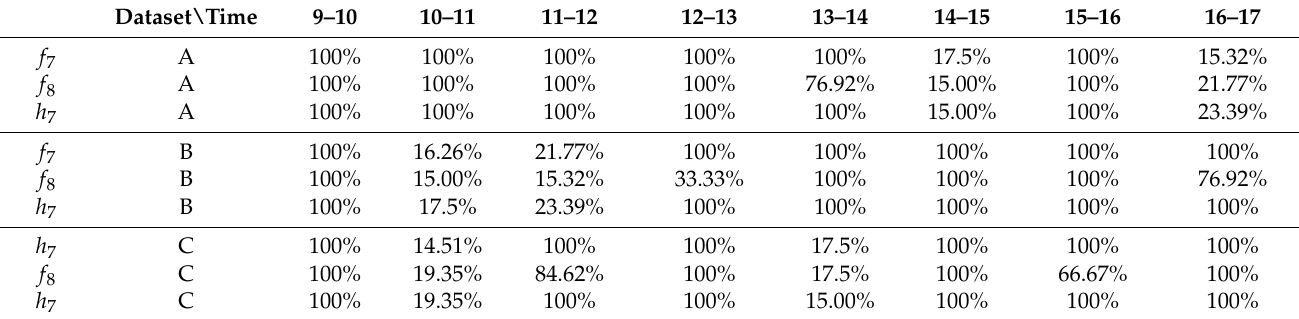
Table 9. Recall for feature sets f 7 , f 8 and h 7 on different datasets.